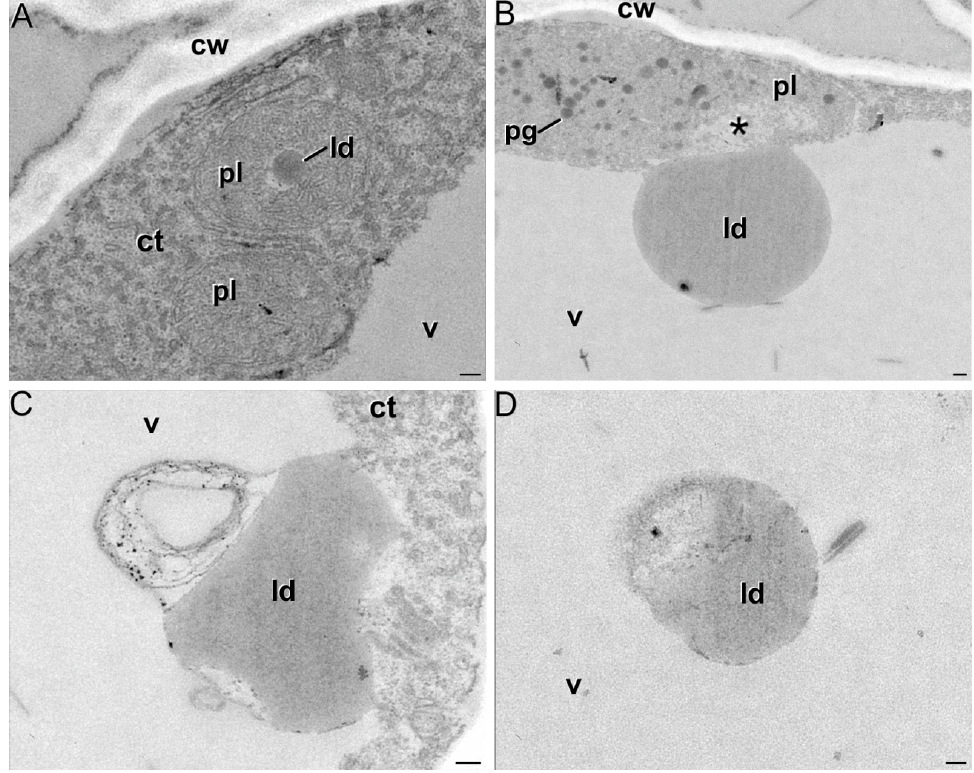
Figure 2. Different stages in lipid droplet transport to the vacuole: ( A ) chromoplast (pl) with a lipid droplet (ld) within; ( B ) droplet being transferred to the vacuole (v) and leaving an empty space (asterisk) in the chromoplast; ( C ) entire chromoplast being degraded while entering the vacuole; and ( D ) lipid droplet being degraded once in the vacuole; ct: cytoplasm; cw: cell wall; pg: plastoglobule. Bars: 100 nm.